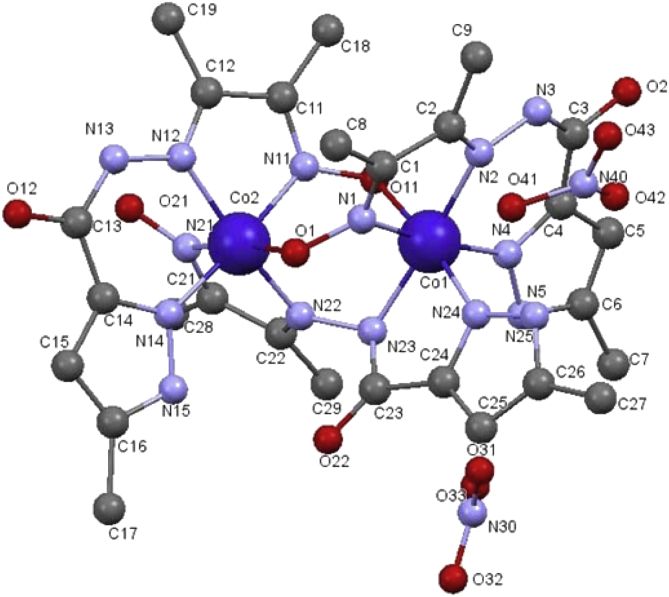
Molecular structure of complex 1 with atom numbering scheme. Hydrogen atoms and nitrate counter-ions were excluded for clarity. Selected bond distances (Ǻ) and angles (°): Co1–O11 1.917 (2), Co1–N1 1.893 (3), Co1–N2 1.932 (3), Co1–N4 1.926 (3), Co1–N23 1.945 (2), Co1–N24 1.906 (3), Co2–O1 1.976 (2), Co2–N11 1.879 (3), Co2–N12 1.939 (3), Co2–N14 1.908 (3), Co2–N21 1.899 (3), Co2–N22 1.873 (3), O2–C3 1.284 (4), O12–C13 1.229 (5), O22–C23 1.224 (4); O11–Co1–N1 91.87 (11), O11–Co1–N2 89.84 (11), O11–Co1–N4 89.34 (11), O11–Co1–N23 92.01 (11), O11–Co1–N24 172.41 (11), N1–Co1–N2 81.27 (12), N1–Co1–N4 172.29 (11), N1–Co1–N23 91.77 (12), N1–Co1–N24 88.51 (13), N2–Co1–N4 91.12 (12), N2–Co1–N23 172.86 (12), N2–Co1–N24 97.71 (12), N4–Co1–N23 95.80 (12), N4–Co1–N24 91.29 (13), N23–Co1–N24 80.40 (12), O1–Co2–N11 91.40 (11), N14–Co2–N22 96.19 (13), N21–Co2–N22 82.09 (12). Hydrogen bonds [d (D···A) Å, ∠(DHA) °]: N5–H5A⋅⋅⋅O31 2.885 (5), 152, N15–H15⋅⋅⋅O22 2.883 (4), 139, O21–H21⋅⋅⋅N12 2.811 (5), 133, O21–H21⋅⋅⋅N13 3.314 (5), 149, N25–H25A⋅⋅⋅O12i 2.969 (5), 120, N25–H25A⋅⋅⋅O42 2.767 (7), 158. Symmetry operation i) -1+x,y,z.